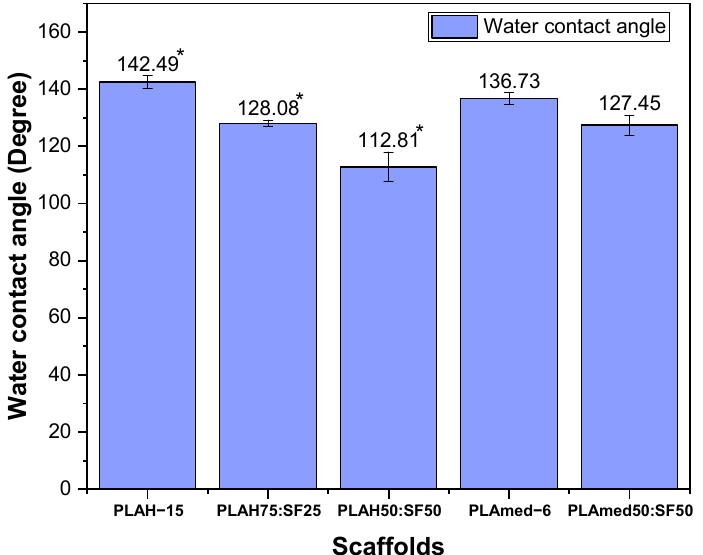
Figure 9. Water contact angle of PLAH − 15, PLAH75:SF25, PLAH50:SF50, PLAmed − 6, and PLAmed50:SF50 scaffolds; * From previous study [31].